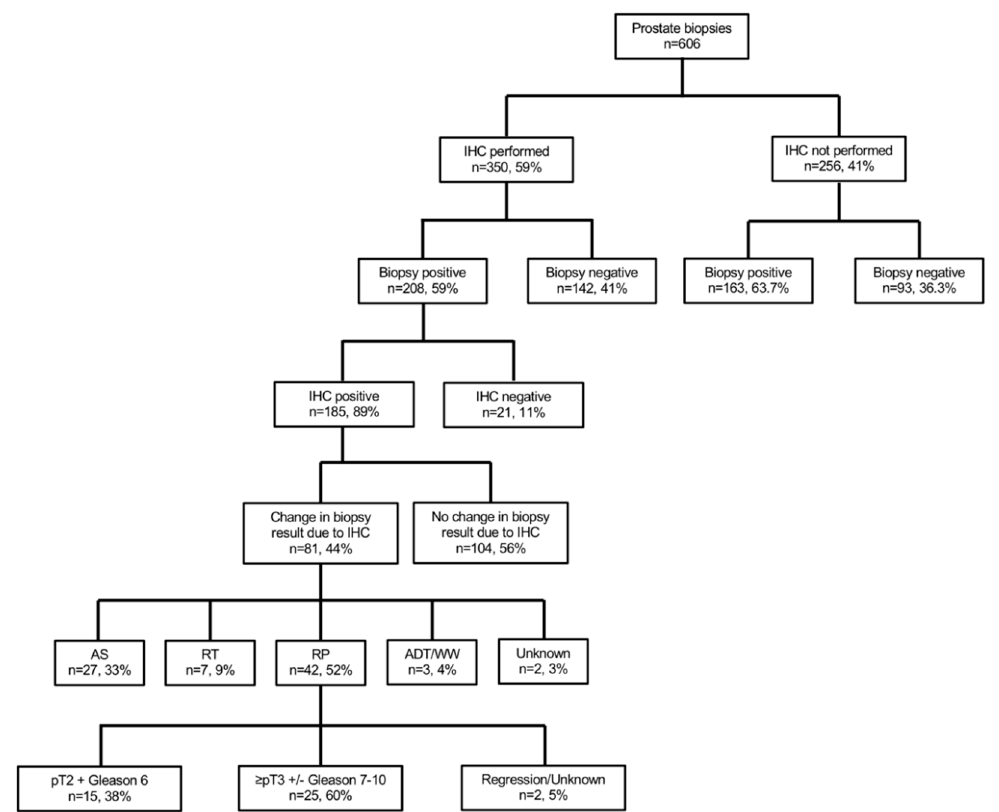
Figure 1. Flow chart depicting the performed subgroup and sensitivity analyses of 606 patients who underwent prostate biopsy at University Hospital Frankfurt between January 2017 and June 2020. Abbreviations: IHC—immunohistochemistry; AS—active surveillance; RT—radiation therapy; RP—radical prostatectomy; ADT—androgen deprivation therapy; WW—watchful waiting.